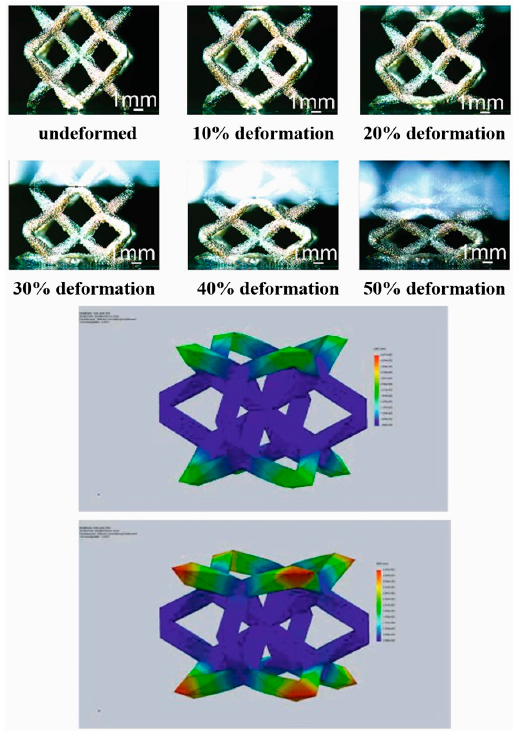
Figure 9. Single rhombi-dodecahedron unit cell of 316L SLM with a relative density of 12% at different deformation levels and calculated deformation curves from a FEM simulation.